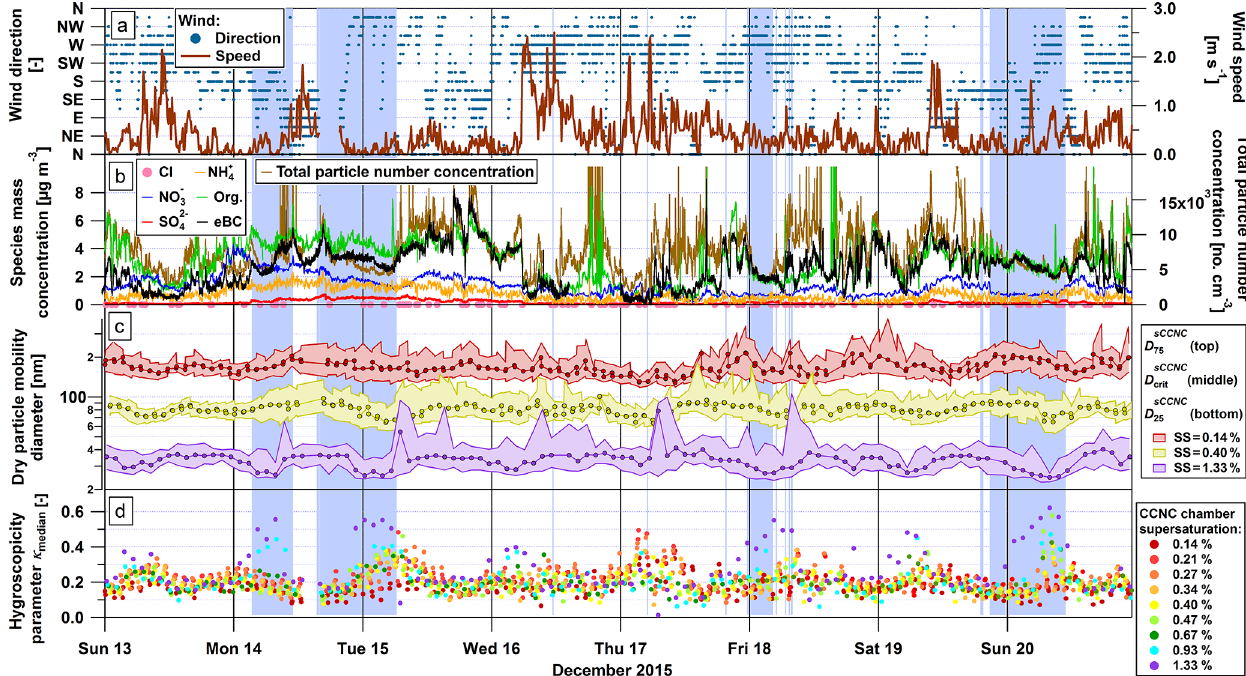
Figure 4. Time series of various parameters during the period of the analysed fog events (blue shadings): (a) wind speed and direc- tion; (b) mass concentrations of organics, inorganic species, eBC as well as total particle number concentration ( D> 7nm); (c) dry particle mobility diameters corresponding to 25%, 50% ( D sCCNC ) and 75% sCCNC-activated fraction at the SS applied in the sCCNC; (d) retrieved crit κ median value for each sCCNC scan. Note that the measurements at different SS are representative of different particle sizes (see panel c ). Thus, the dependence of the κ median values shown in panel (d) primarily reflects the size dependence of particle